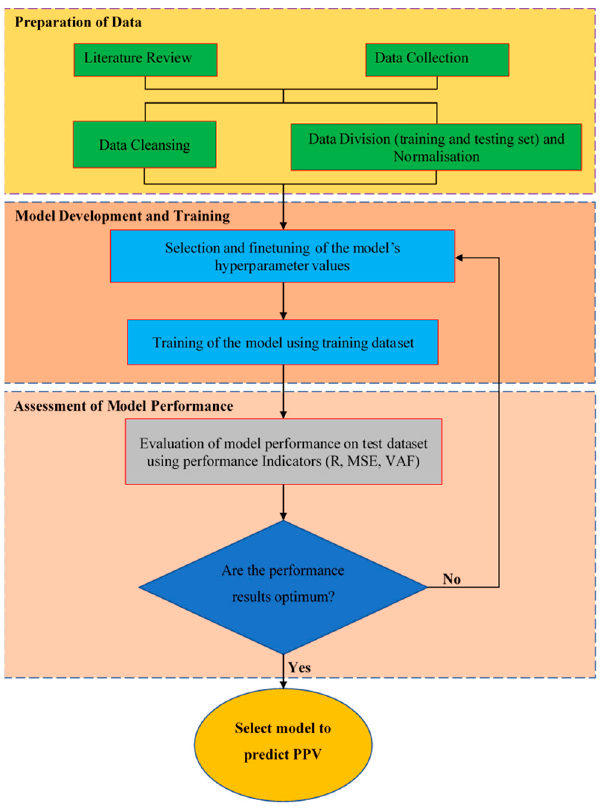
Figure 5. A Systematic Flowchart for Prediction of Blast-Induced Ground Vibration.